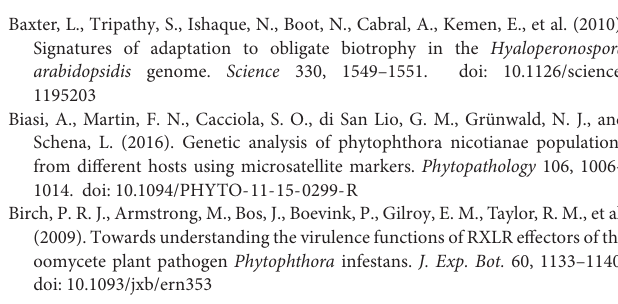
Supplementary Figure 1 | Overall pipeline used for secretome and effector prediction. Supplementary Figure 2 | (A) Pearson’s correlation coefficient of SSR number and Genome size. Result indicates number of SSRs positively correlated with genome size. (B) There was weak negative correlation between SSR density and genome size. (C) Number of SSR motifs shows weak negative correlation with genome size. (D) GC percentage of genome and SSR are positively correlated. Supplementary Figure 3 | Heatmap depicts the percentage frequency of trinucleotide SSR group motifs in the coding sequences (CDS). There is a clear abundance of CAG/CTG, AAG/CTT motifs. Supplementary Figure 4 | Heatmap depicts the in-frame cumulative frequency of trinucleotide SSR motifs in the coding sequences (CDS). There is a clear dominance of CAG, CTG, AAG motifs. Supplementary Figure 5 | Effector prediction pipeline containing the number of proteins filtered out in each step. The first bar chart (bottom most) (light green) represents the genome sizes of 128 Phytophthora isolates studied. The second bar chart (ash) represents the total number of Open reading frames (ORFs) predicted by getorf function of EMBOSS package. These ORFs are further translated in one frame and the translated sequences were used for secretome prediction. The third bar chart (pink) shows the number of secretory proteins containing signal peptide (SP), based on SignalP v. 5.0b prediction. The fourth one (brown) shows the number of secretory proteins retained after the TMHMM analysis that does not contain any TransMembrane Helices (TMHs). The fifth one (violet) shows the number of secretory proteins that passed TargetP analysis. These retained proteins after the TargetP are used for effector prediction using EffectorO. The sixth bar chart (red) shows the number of predicted effectors for each genome. The seventh bar plot (green) represents the number of predicted RxLR effectors among the predicted effectors, predicted by homology searching. The eight (orange) and the last one (blue) show the number of effectors containing the CRN motif and the number of effectors containing the WYL domain respectively. Supplementary Figure 6 | Box plots of FIRs of all genes, BUSCO genes and RxLRs in all the studied species. Here the positive FIR values were plotted with whisker = 0.2